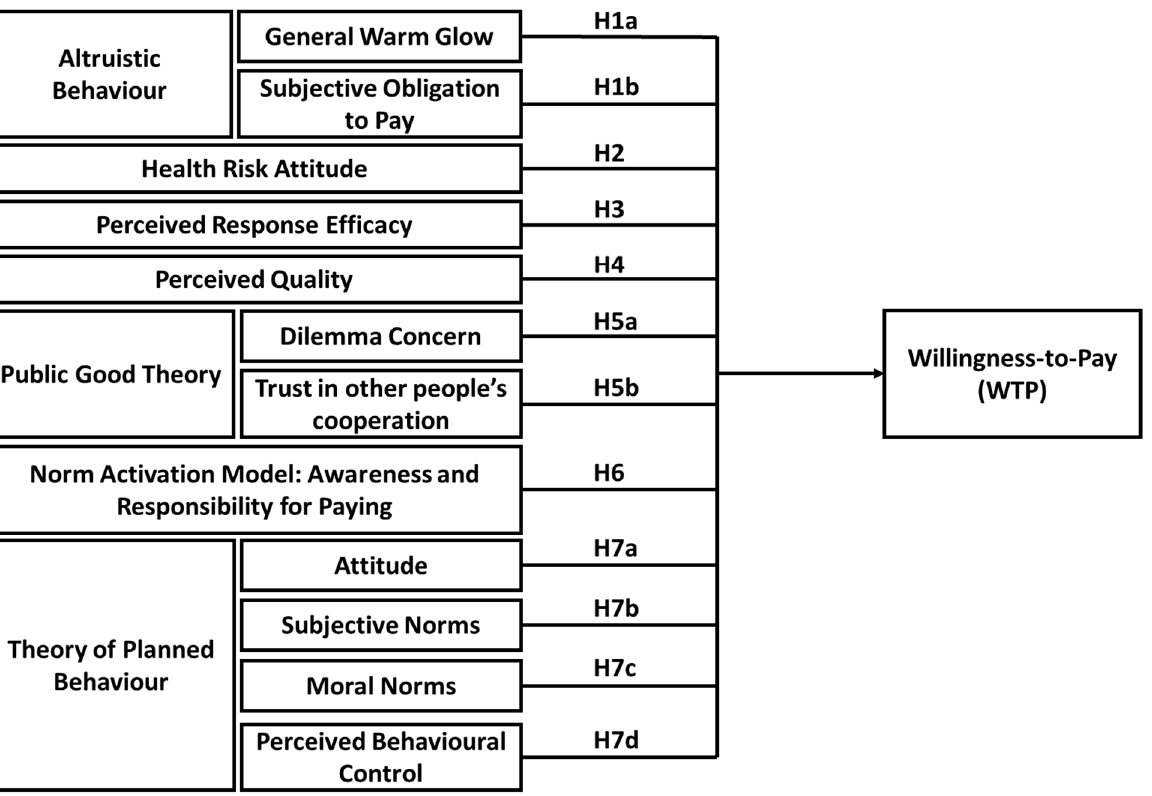
Figure 3. Conceptual Model.